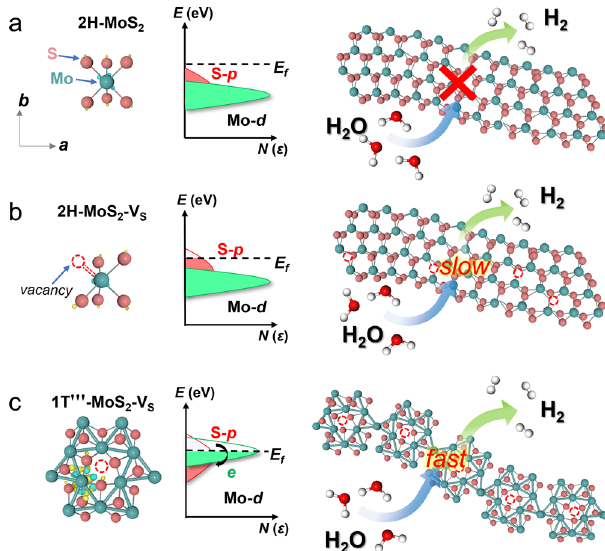
Fig. 1 | Schematic illustration of charge self-regulation effect on manipulating active electronic states. a 2H-MoS 2 , ( b ) 2H-MoS 2 -V S without Mo − Mo bonds (Only gapstatesaroundtheFermilevelinducedbySatom)and( c )1T'''-MoS 2 -V S withMo − Mo bonds (Charge transfers from activated Mo − Mo bonds to S atoms due to uplifted states of Mo − Mo bonds). H 2 O can be electrocatalytically reduced to H 2 through 2H-MoS 2 -V S and 1T'''-MoS 2 -V S under ambient conditions. The yellow and blue regions indicate the accumulation of positive and negative charge,